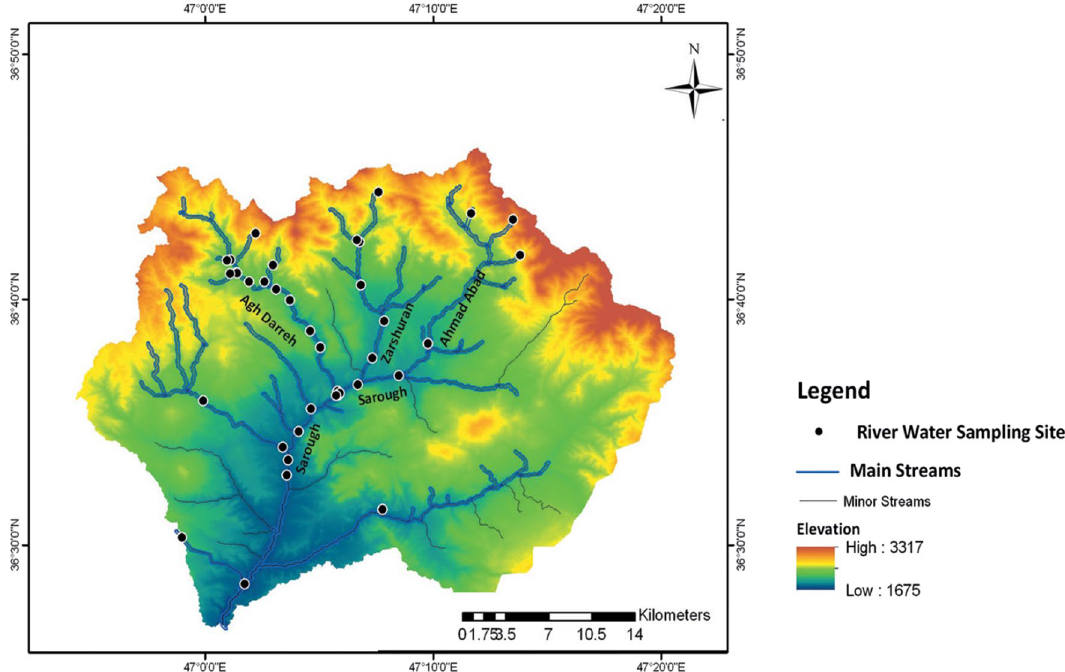
Figure 2. Location map of main streams in Sarouq watershed and sampling sites. (This figure was created in the Quantum GIS, version